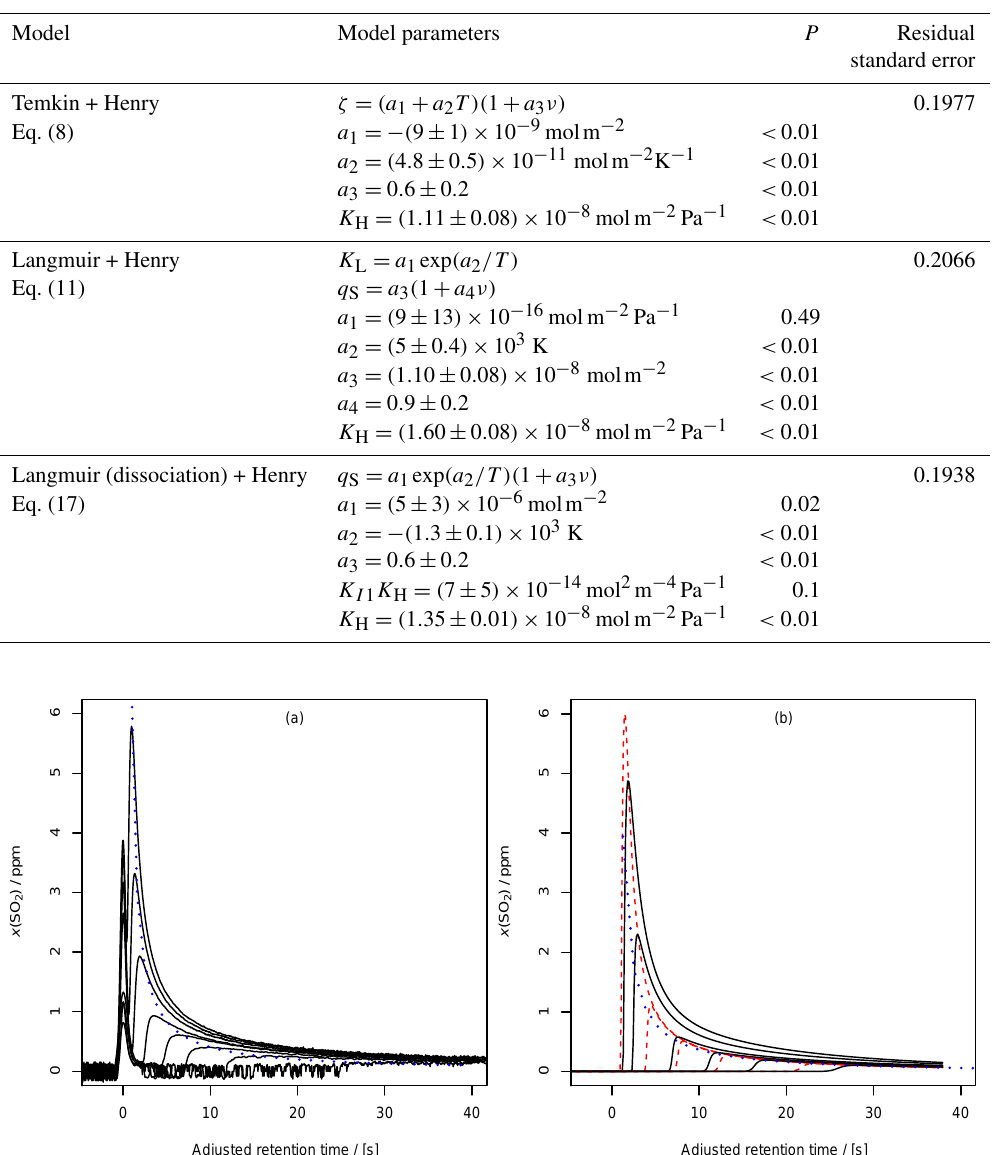
Table 1. Nonlinear fit of the experimental data with the humidified carrier gas and h > 4µm to different models. The binary variable ν denotes if the column was aged ( ν = 1) or not ( ν = 0).